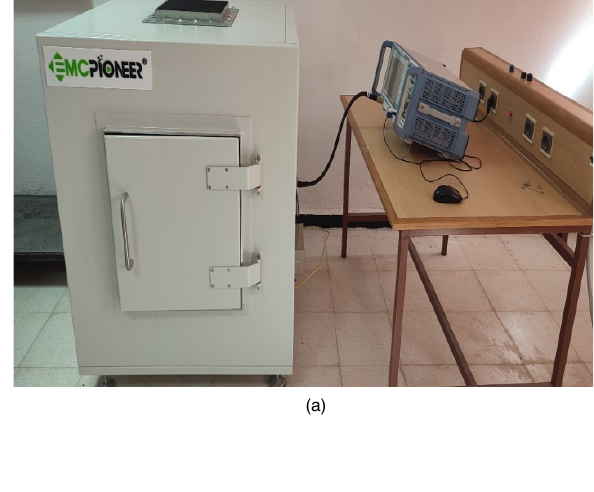
TABLE I. The designed antenna comparative analysis with other UWB antennas